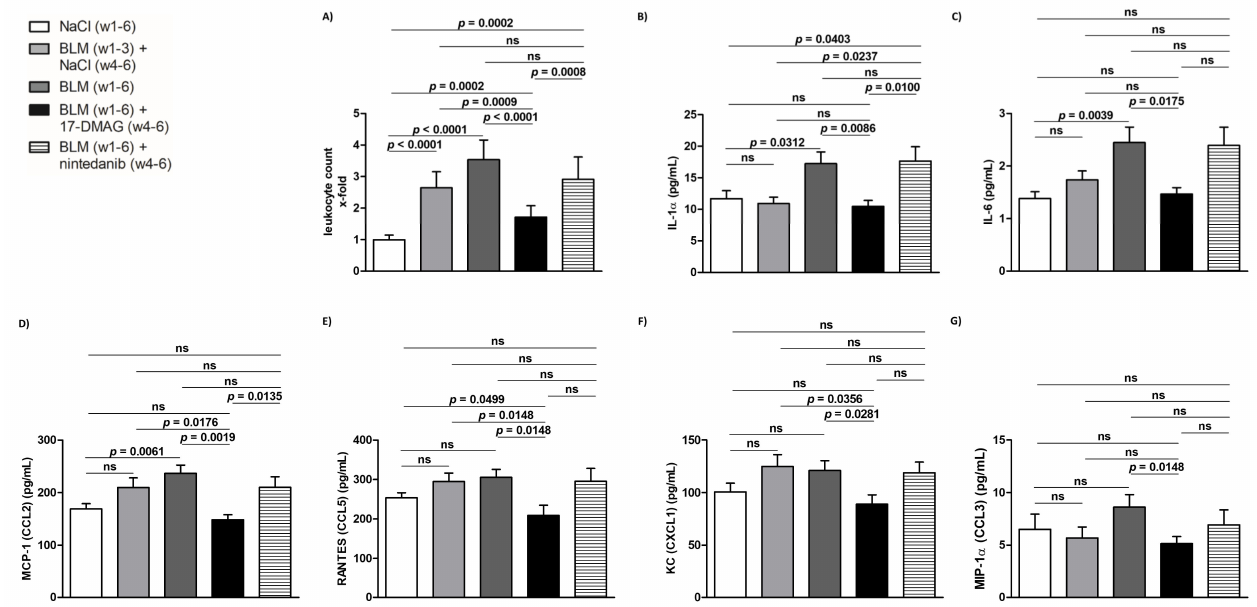
Figure 6. Treatment with 17-DMAG strongly downregulates the local and systemic proinflammatory response induced by bleomycin. Treatment with 17-DMAG significantly reduced the number of leukocytes infiltrating the lesional skin ( A ), and the serum levels of interleukin (IL)-1 α ( B ), IL-6 ( C ), monocyte chemoattractant protein-1 (MCP-1, CCL2) ( D ), regulated on activation/normal T cell expressed and secreted (RANTES, CCL5) ( E ), keratinocytes-derived chemokine (KC, CXCL1) ( F ), and macrophage inflammatory proteins-1 α (MIP1 α , CCL3) ( G ). Columns represent the mean and whiskers represent the standard error of the mean. w, week; NaCl, sodium chloride; BLM, bleomycin; 17-DMAG, 17-dimethylaminoethylamino-17- demethoxygeldanamycin (inhibitor of heat shock protein 90); ns, not significant ( p ≥ 0.05); n = 8 mice in each